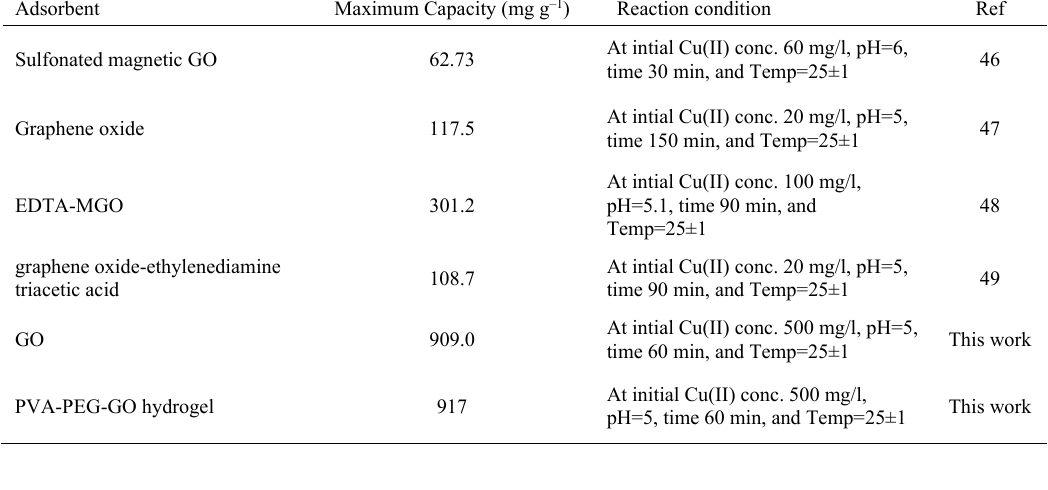
Table 3: Comparison of maximum adsorption capacity of Cu (II) on various adsorptions